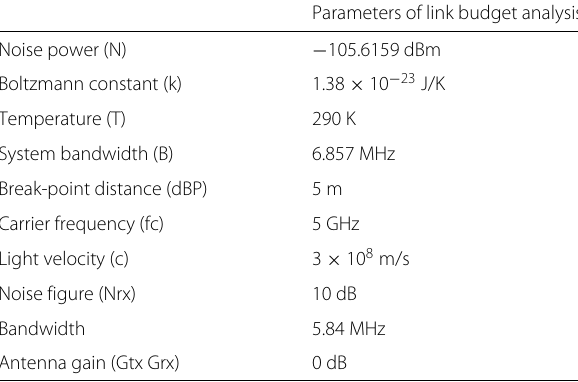
Table 3 Link budget